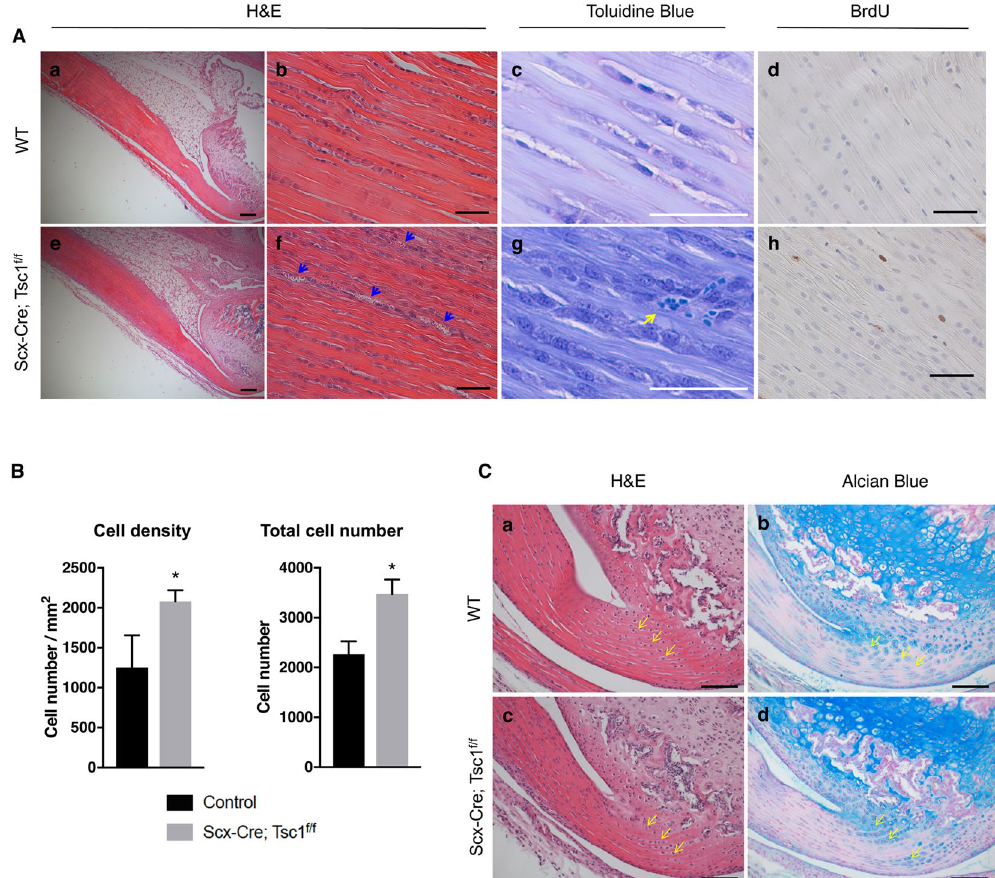
Figure 4. Gain of mTORC1 signaling induces abnormalities in Achilles tendons. ( A ) Histology of Achilles tendons from wild-type (WT) (a-d) and Scx-Cre; Tsc1 f/f littermates (e–h) at postnatal day 30 (P30). Low magnification (5X) image of Hematoxylin and Eosin (H&E) staining of Achilles tendons (a and e). High magnification image (40X) of H&E (b and f), toluidine blue (c and g), and BrdU (d and h) staining of the midsubstance of Achilles tendons. Blue arrows and yellow arrow indicate vascularization. Scale bars in a and e indicate 200 μ m, and all other scale bars indicate 50 μ m. ( B ) Quantification of cell density and total cell number using H&E-stained sections of Achilles tendons (n = 3, * p < 0 . 05 ). ( C ) H&E staining of the enthesis of the Achilles tendon from WT (a) and Scx-Cre; Tsc1 f/f littermates (c) at P30. Alcian blue staining of the enthesis of Achilles tendons from WT (b) and Scx-Cre; Tsc1 f/f littermates (d) at P30. Yellow arrows indicate representative fibrocartilage cells. Scale bars indicate 100 μ